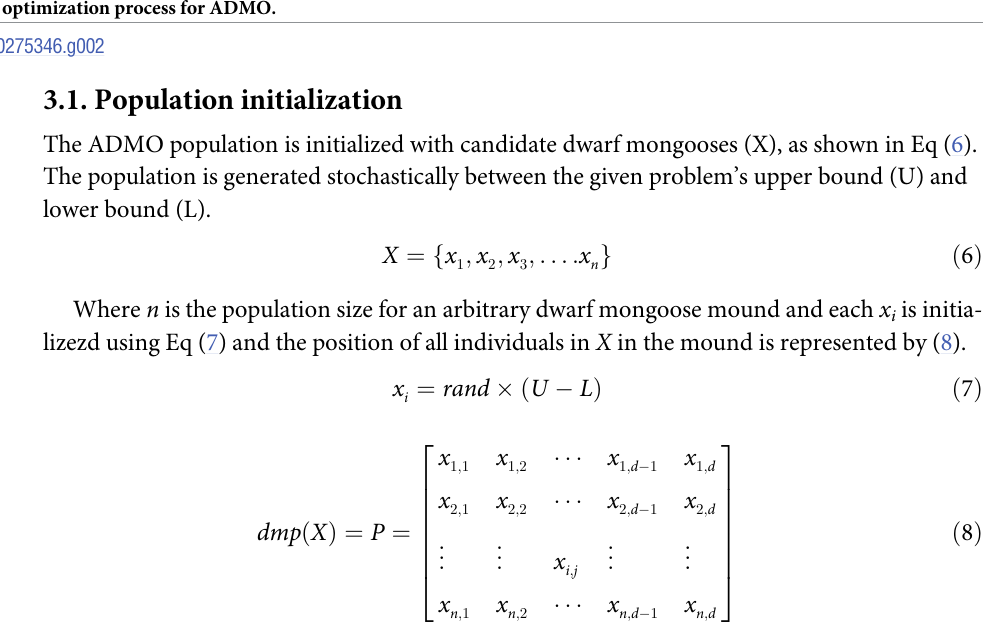
Fig 2. The model of the proposed optimization process for